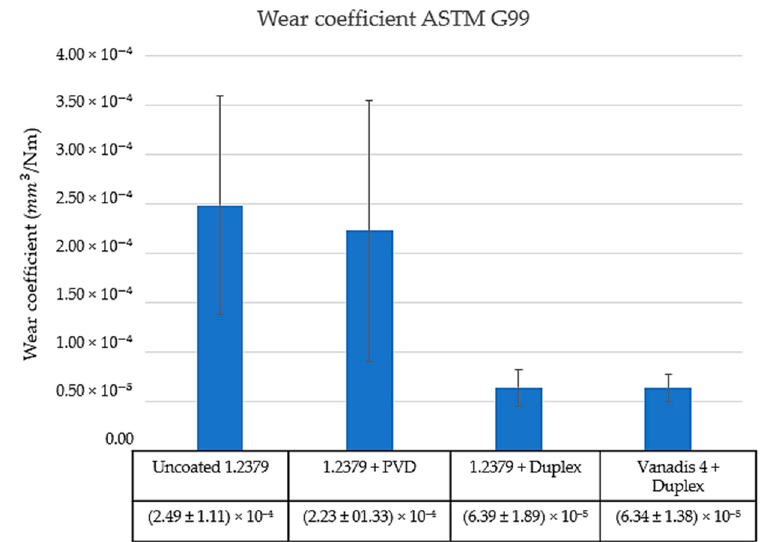
Figure 10. Comparative graph of the wear coefficient values calculated by ASTM G99 for each sample.